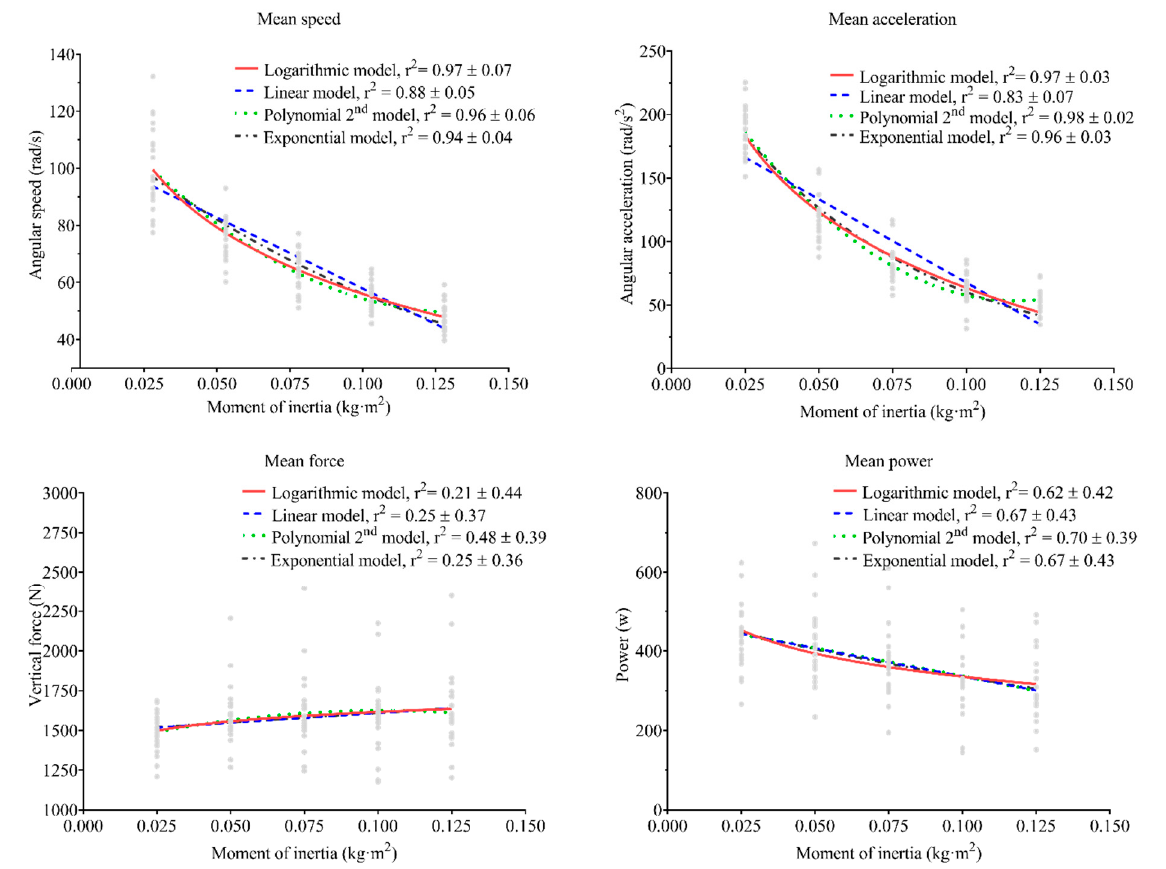
Figure 1. Association between each mechanical variable and the moment of inertia used, with different fitting models. r 2 shows the mean ± standard deviation coefficient of determination for each model. The lines represent the regression line for each model, while the gray points represent individual values for each subject.